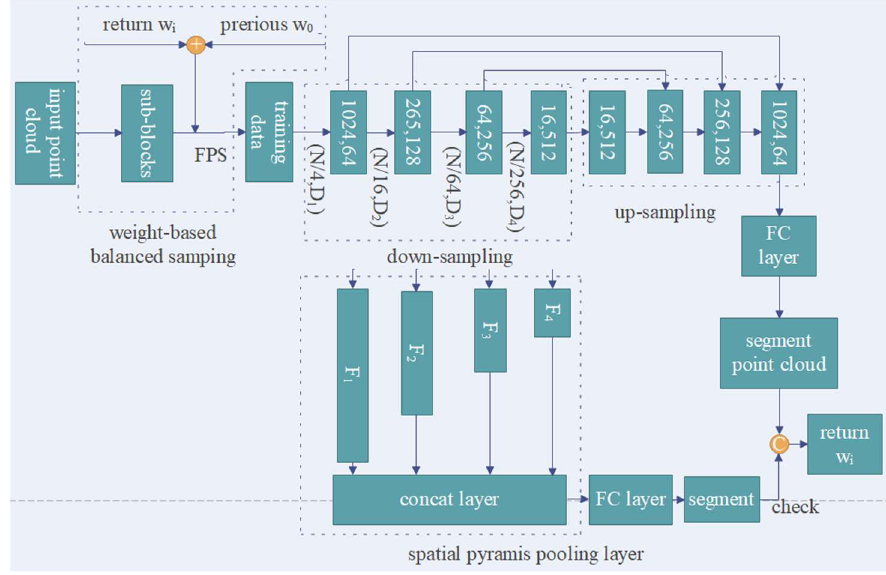
Figure 3. Overall structure of network.